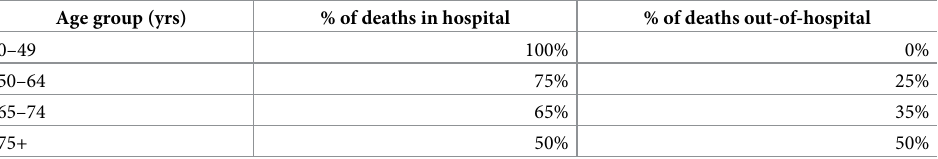
Table 4. Proportion of mortality events occurring in- and out-of-hospital (informed using data from Table 3 of Matias et al . [48]).